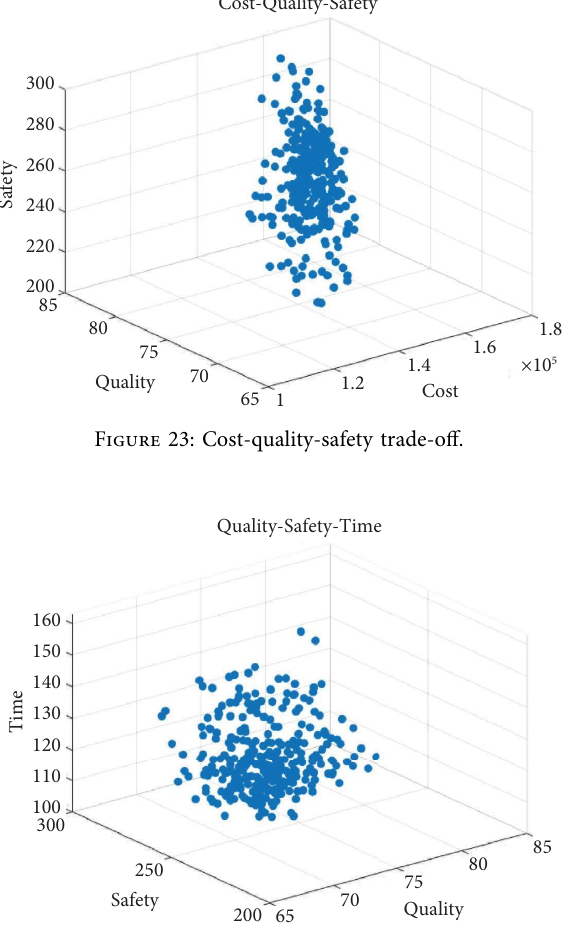
Figure 24: Quality-safety-time